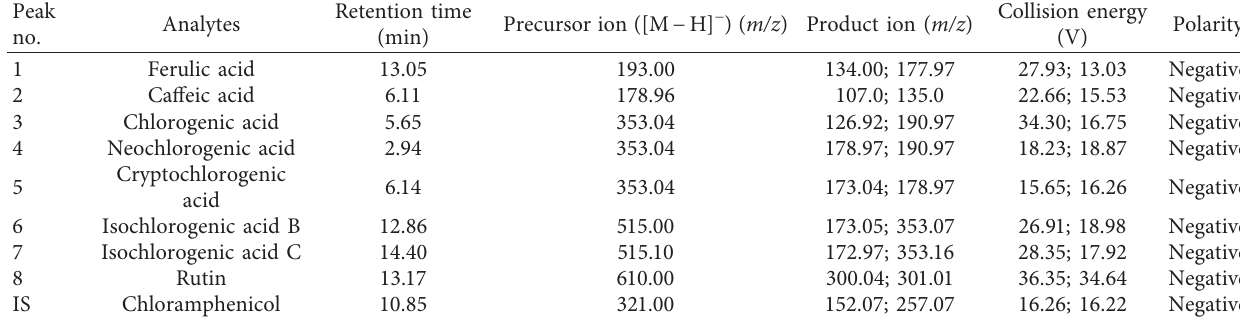
Table 1: Optimized SRM parameters of 8 analytes and